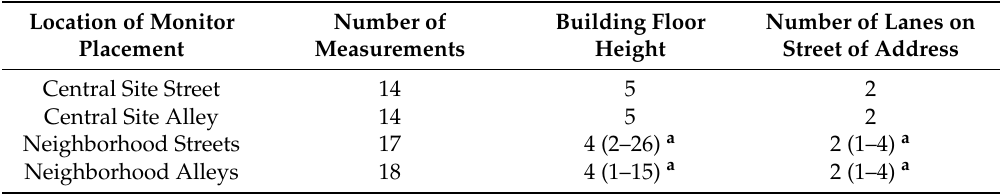
Table 1. Building